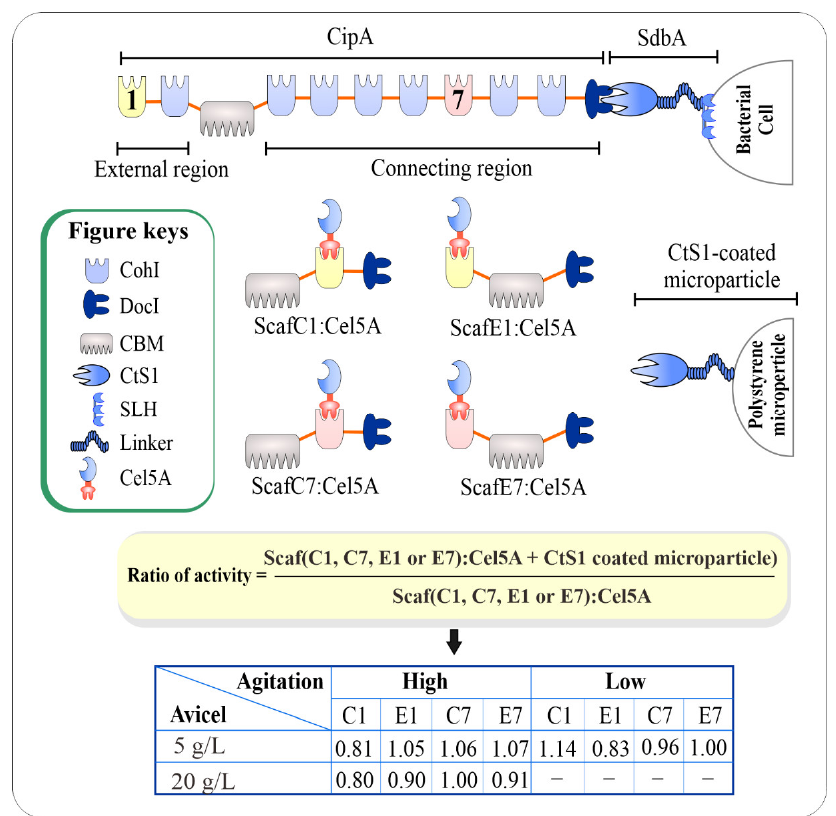
Figure 6. (From the top) The CohI located in the external and connecting regions on the CipA scaffoldin protein were used to construct mini-Scaf. Mechanically unstable Coh1 was positioned between CBM3a and DocII (ScafC1) or outside of the CBM3a (ScafE1), and mechanically stable Coh7 was placed between CBM3a and DocII (ScafC7) or outside of the CBM3a (ScafE7). The complexations of ScafC1:Cel5A, ScafE1:Cel5A, ScafC7:Cel5A, and ScafE7:Cel5A was bound to CtS1- coated microparticle for biomimetic cellulosome